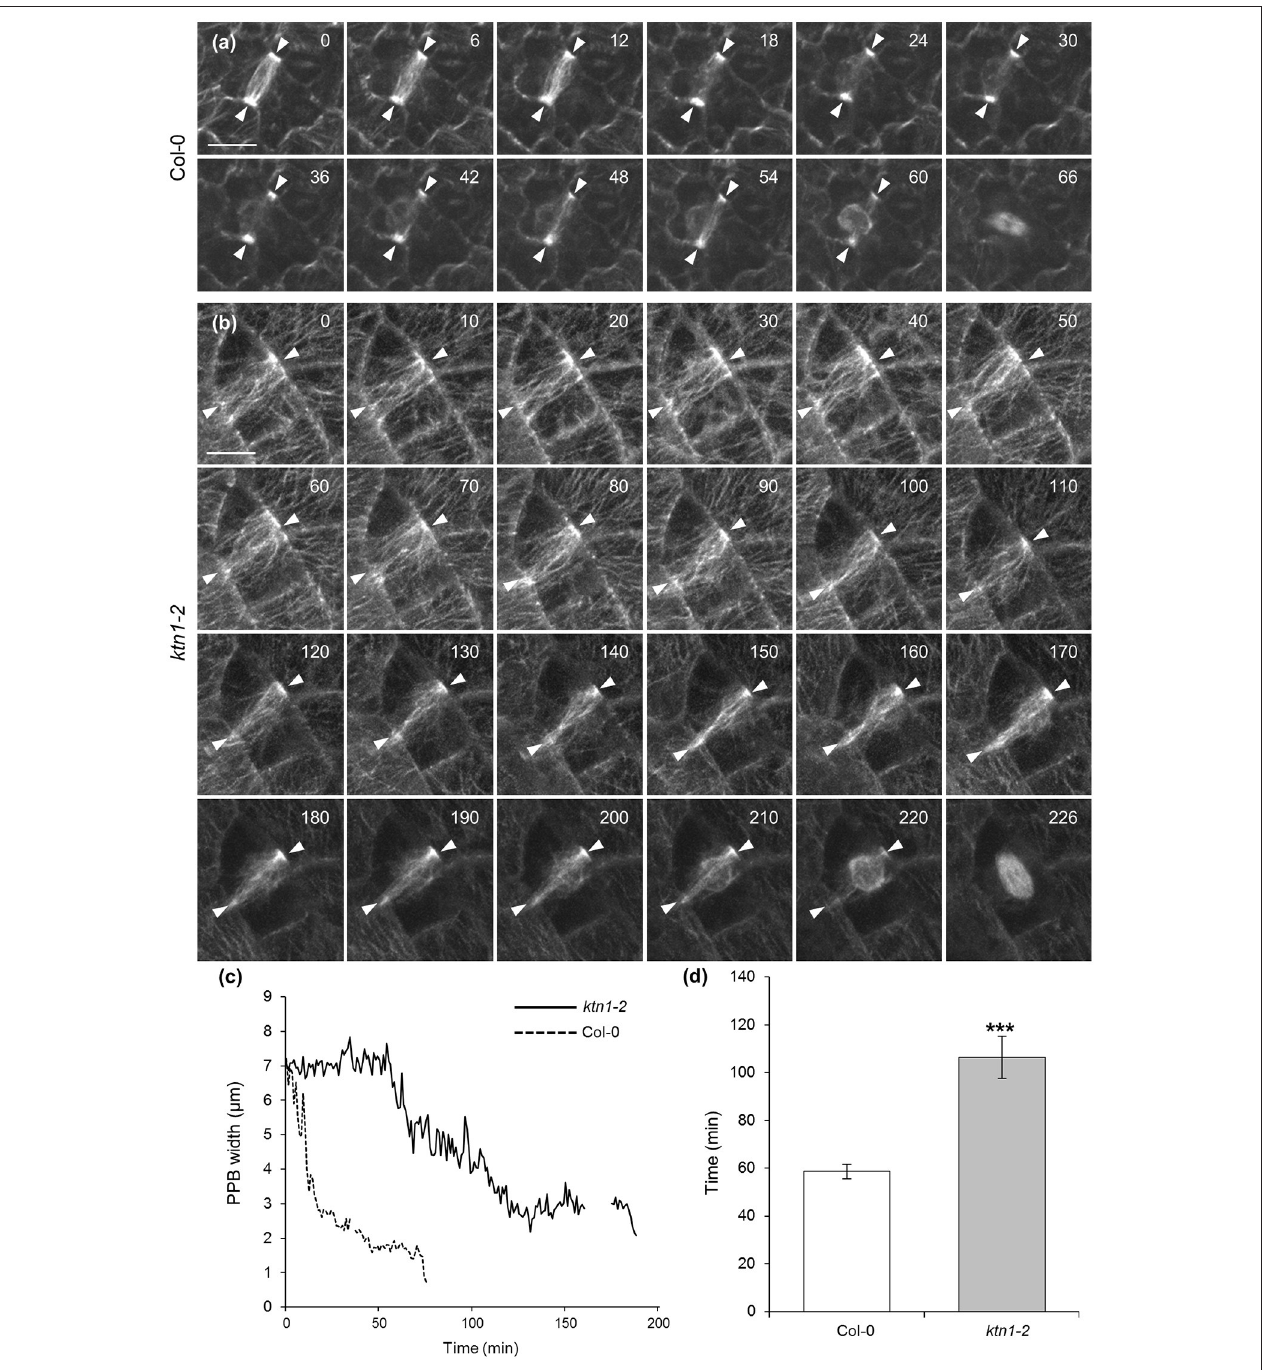
FIGURE 7 | Documentation and quantitation of PPB narrowing in dividing cells of Col-0 and ktn1-2 mutant expressing a GFP-TUA6 microtubule marker after spinning disc time-lapse 2D imaging. (a) Selected stills from the Video S4 , showing the progressive narrowing of the PPB (arrowheads) in a Col-0 epidermal cell until entry in mitosis. (b) Selected stills from the Videos S5 , S6 (continuation of mitotic progress of this cell is shown in Figure 9b) , showing the progressive narrowing of the PPB (brackets) in a ktn1-2 epidermal cell until entry in mitosis. (c) Line graph following the course of PPB narrowing by comparison between a Col-0 and a ktn1-2 cell, showing significant delay in the latter. Interruptions in the lines correspond to interruptions in the recordings. (d) Averaged kinetic documentation of PPB narrowing ( N = 6–7 cells from a total of 5 plants) showing significant delay of PPB narrowing in the ktn1-2 mutant (*** p < 0.001). Scale bars: 10 µ m. Numbers in (a,b) correspond to time